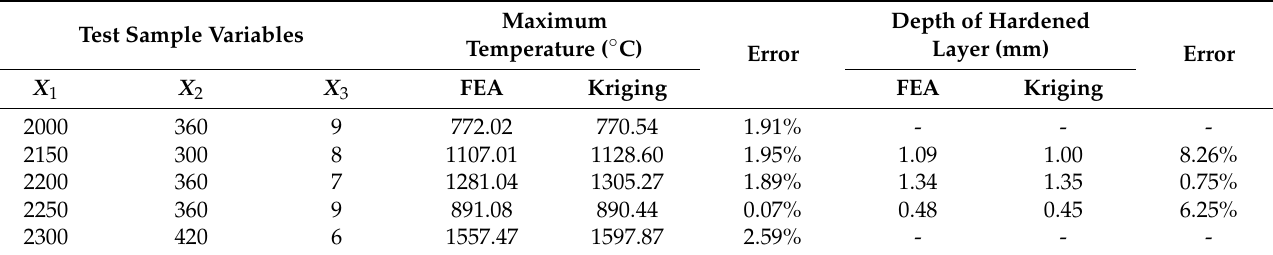
Table 6. Comparison of Kriging model prediction results and finite element results.